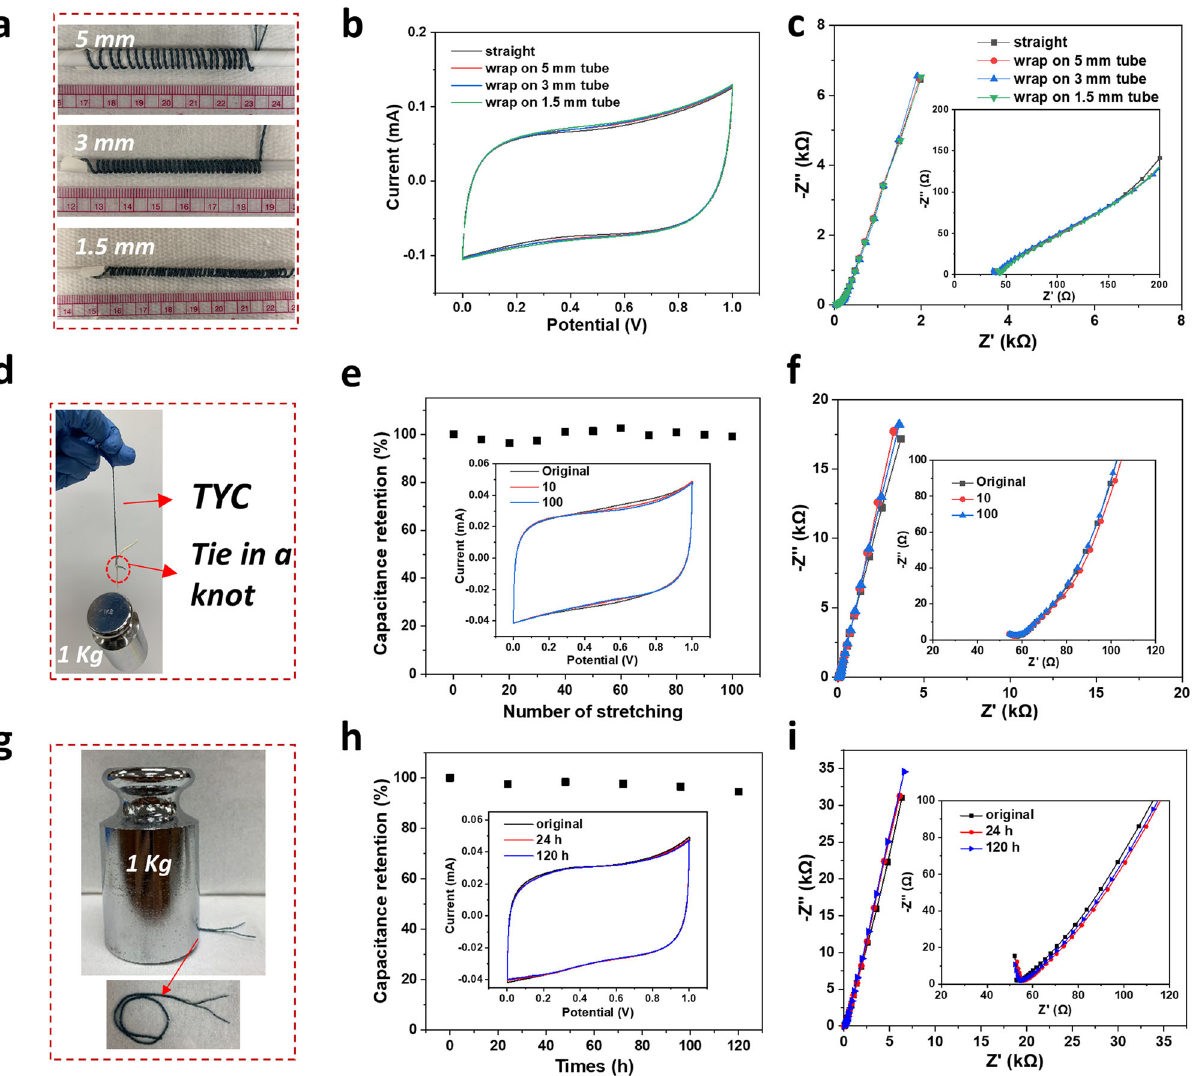
Fig. 3 Stability of TYCs against mechanical deformation. a Photos of TYCs wrapped on tubes in diameters of 5 mm, 3 mm, and 1.5 mm, respectively; b , c CV curves (40 mV s − 1 ) ( b ) and Nyquist plots (1 M – 0.01 Hz), with the inset fi gure zoomed in at the high-frequency domain of the plots ( c ) of TYCs in straight state and wrapped on tubes; d Photo of a TYC lifting a 1 kg weight; e capacitance retention of TYC upon numbers of stretching, with the inset fi gure showing the CV curves (40 mV s − 1 ); f Nyquist plots (1 M – 0.01 Hz) of the original, 10th and 100th stretching of the TYC, with the inset fi gure zoomed in at the high-frequency domain of the plots; g Photos of an YSC under compression of a 1 kg weight; h capacitance retention of TYC upon hours of compression, with an inset fi gure showing CV curves (40 mV s − 1 ); i Nyquist plots (1 M – 0.01 Hz) of the TYC under compression for different time periods, with the inset highlighting the high-frequency domain of the